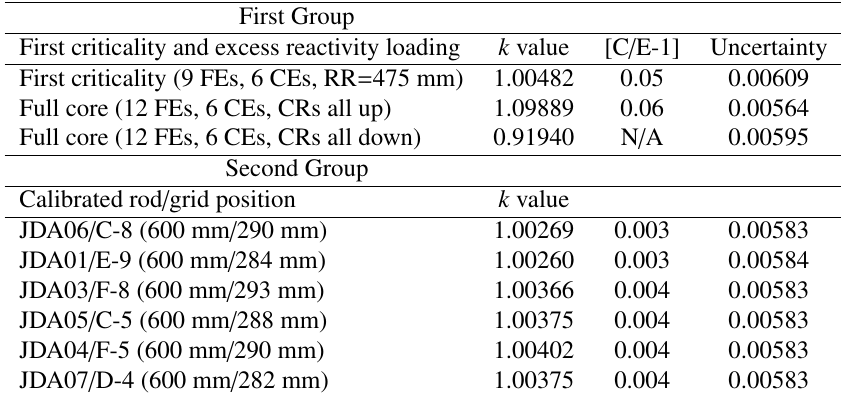
Table 5. Uncertainty analysis result (ENDF /